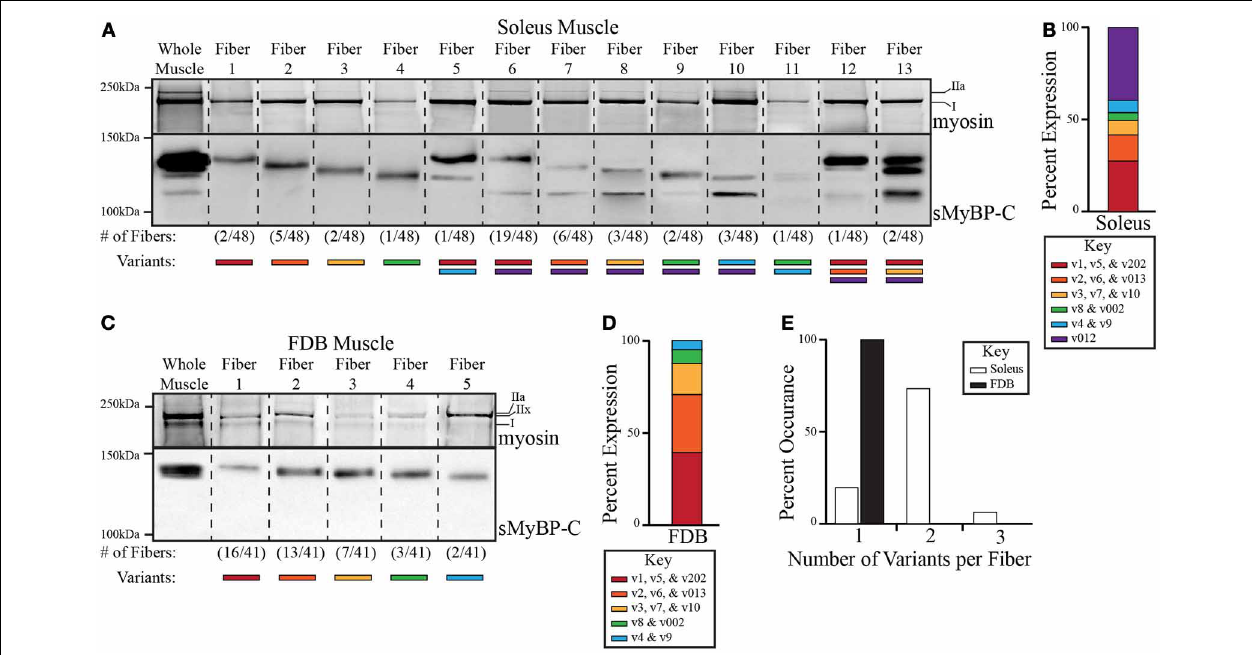
FIGURE 3 | Analysis of the expression profile of sMyBP-C variants in slow twitch soleus and fast twitch FDB skeletal myofibers. Endogenous myosin and sMyBP-C proteins were analyzed in single fibers of adult mouse soleus (A) and FDB (C) muscles. The top part of the gels was stained with SYPRO ruby total protein dye to observe the different myosin isoforms (upper panels), while the bottom part of the gels (lower panels) was processed for immunoblotting using antibodies that recognize epitopes in Ig domain C5, which is present in all known slow variants. Total protein content within each lane was evaluated by Ponceau red staining, and found to be similar. We observed thirteen